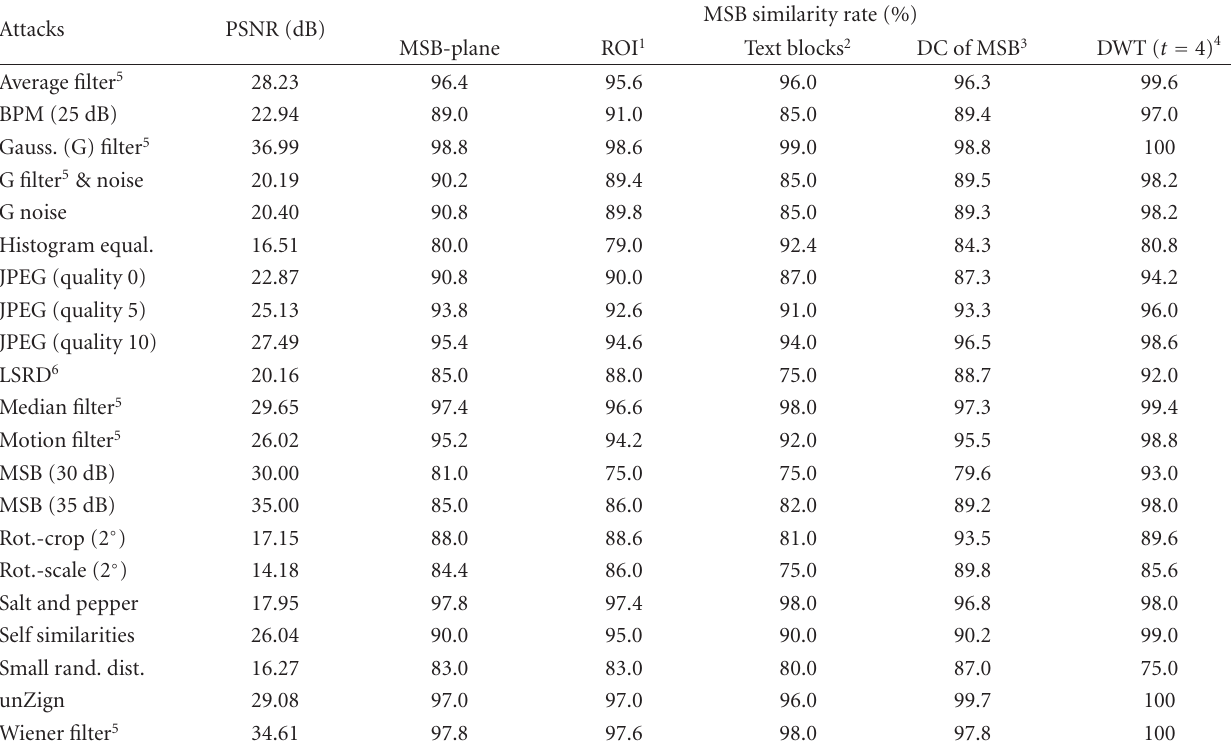
Table 1: Most significant bit (MSB) similarity rate under di ff erent